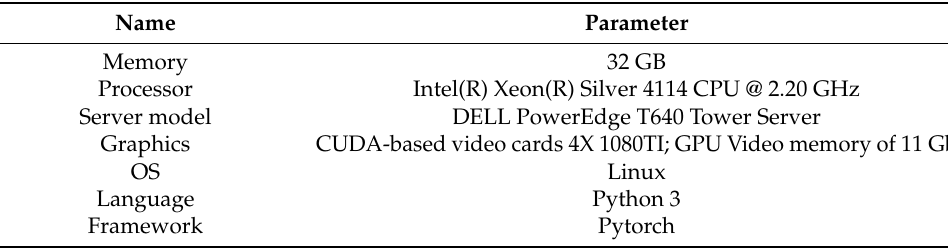
Table 12. Configuration of the machine used.